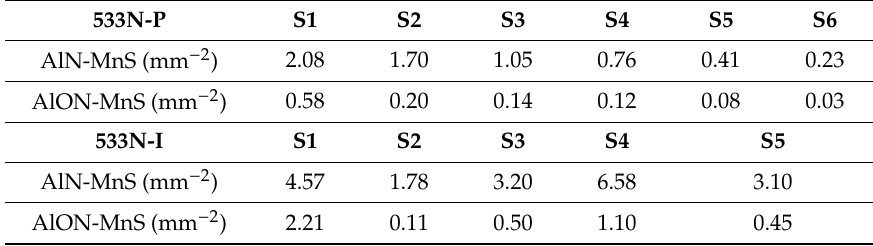
Table 3. The N A values of AlN-MnS and AlON-MnS inclusions in 533N-P and 533N-I steel